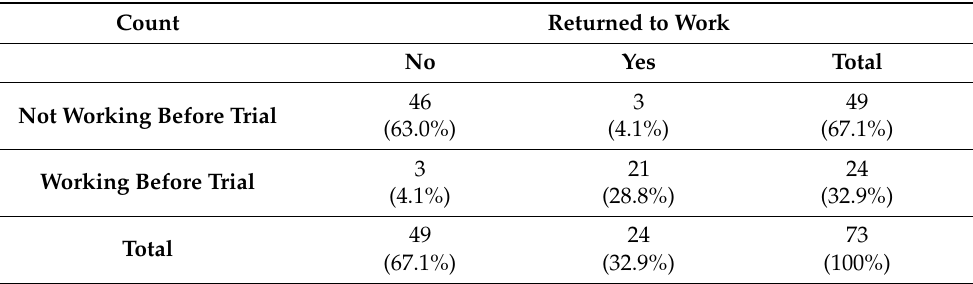
Table 5. Bivariate analysis of work-related outcomes.